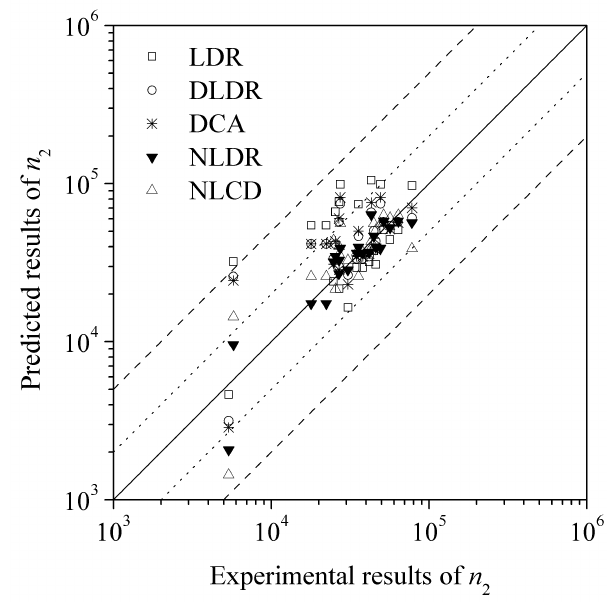
Figure 7. Relative errors of predicted n 2 .